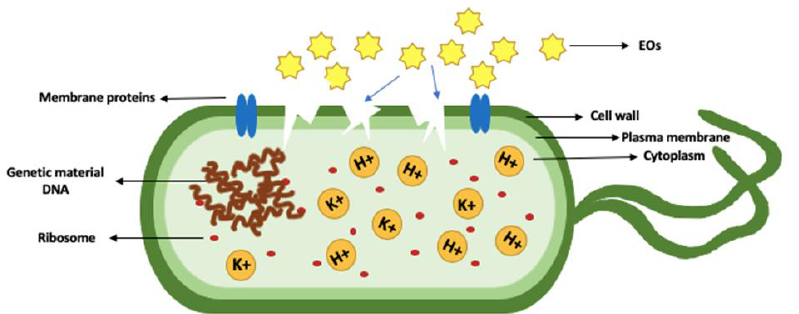
Figure 1. Membrane disruption in a bacterial cell caused by EO leading to the inhibition of bacte- Figure 3. Modifications in ATP levels: ( A ) Normal ATP within the bacterial cell, ( B ) Decreased rial growth. K+ is potassium ion and H+ is hydrogen ion. intracellular and increased extracellular ATP after exposing bacteria to